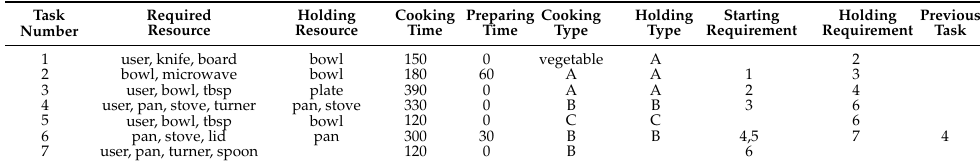
Table 1. Cooking tasks included in hamburger steak